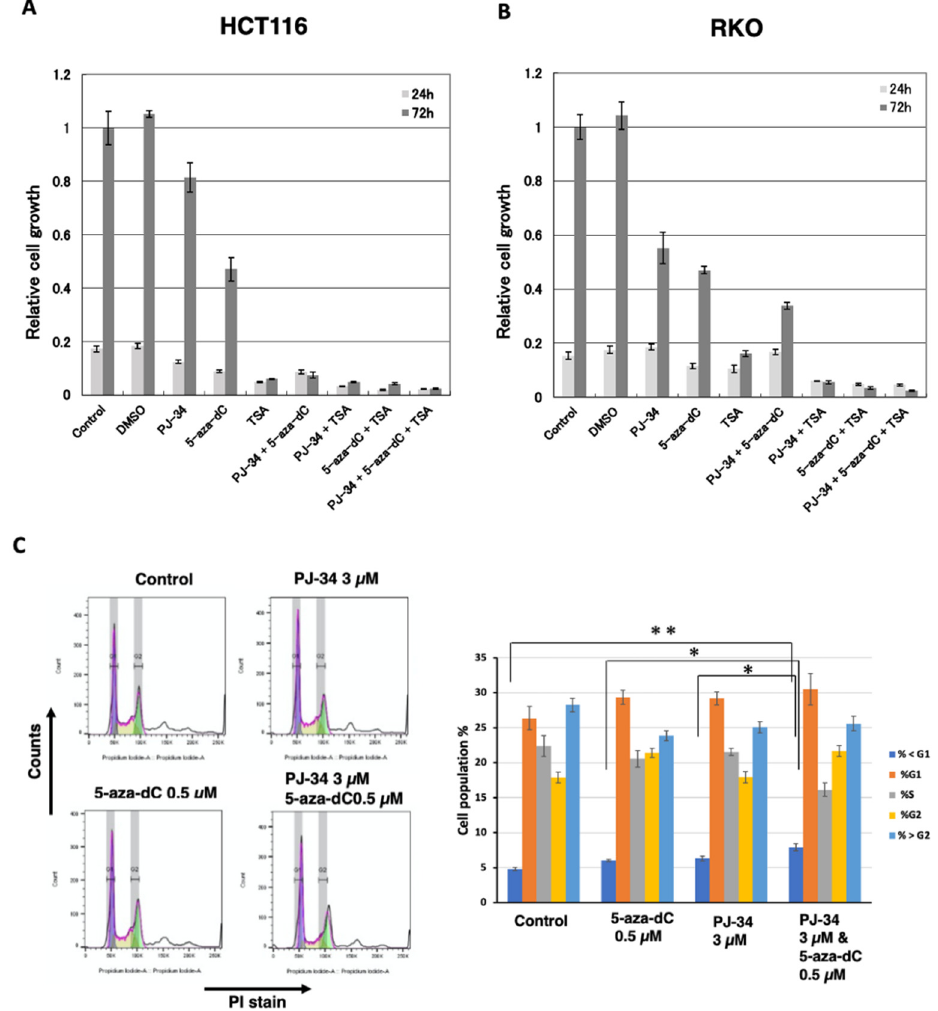
Figure 2. Effects of PJ-34, 5-aza-dC, and TSA in colon cancer HCT116 and RKO cells. ( A , B ) Effects of 3 µM PJ-34, 1 µM 5-aza-dC, and 300 nM TSA on the cell growth in colon cancer HCT116 ( A ) and RKO ( B ) for 3 days. n = 3. Statistical differences are shown in Table S1. ( C ) HCT116 cells were treated with 5-aza-dC, PARP inhibitors PJ-34 for 2 days and analyzed with flow cytometry analysis. The cells were stained with PI. The left panel shows the representative cell cycle distribution. The right panel shows the cell population % of subG1, G1, S, G2, and superG2 fractions. N = 3. Mean ± S.E. Statistical differences in SubG1 % is indicated. * p < 0.05, ** p < 0.01.